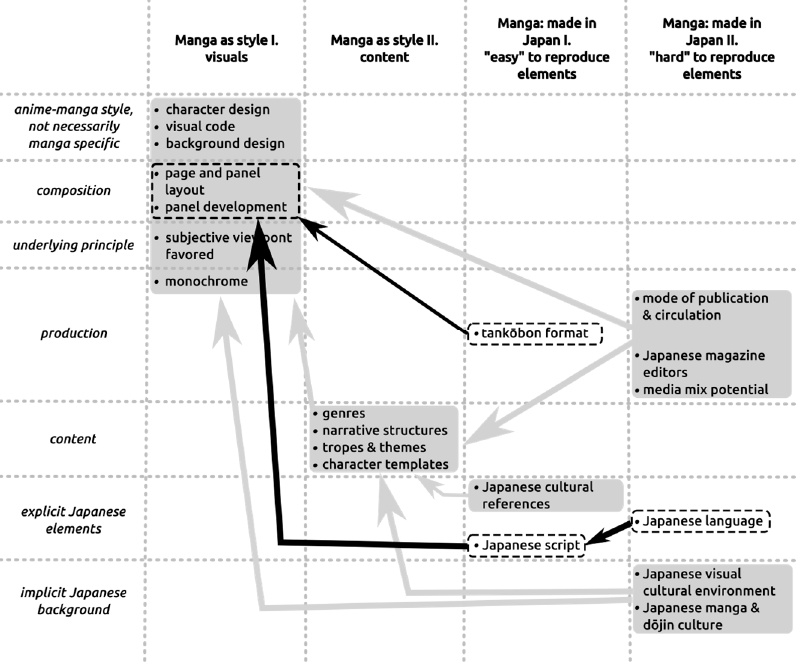
Figure 2. Potential connections between elements of the style and made in Japan positions 32 .